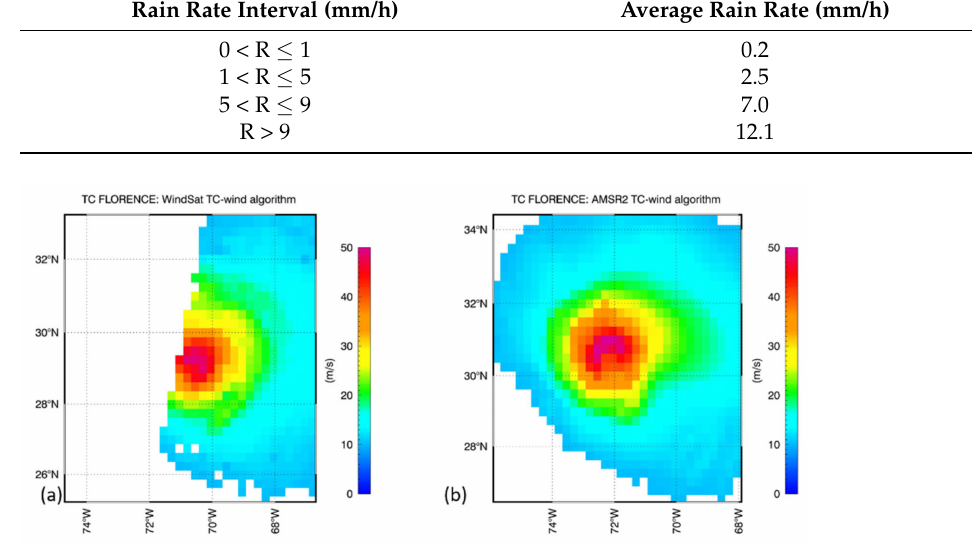
Figure 5. TC-wind speed retrievals for the Hurricane Florence overpasses from Figure 1 of WindSat ( a ) and AMSR2 ( b ). Note, that the color bars in Figures 1 and 5 are